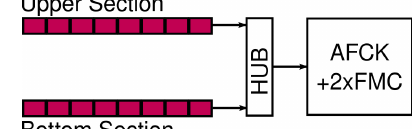
Figure 37. Demonstration